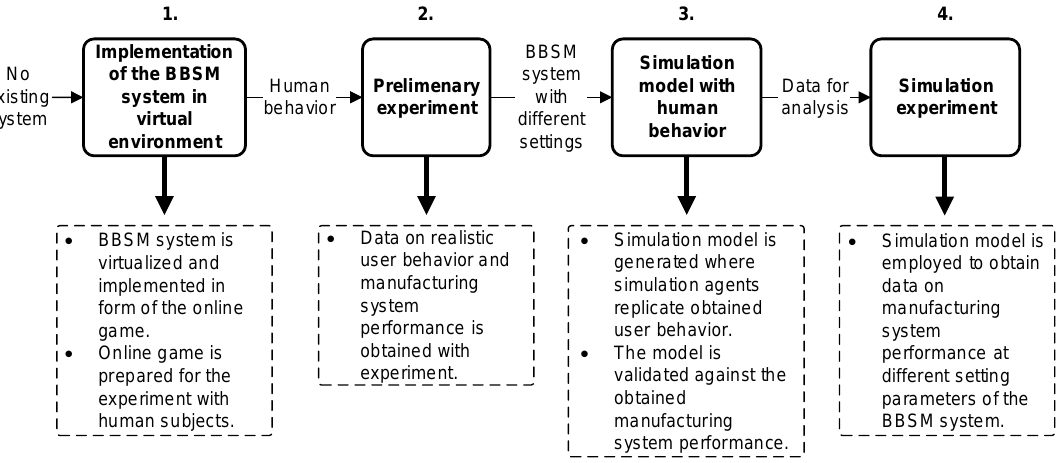
Figure 1. Methodology employed for the